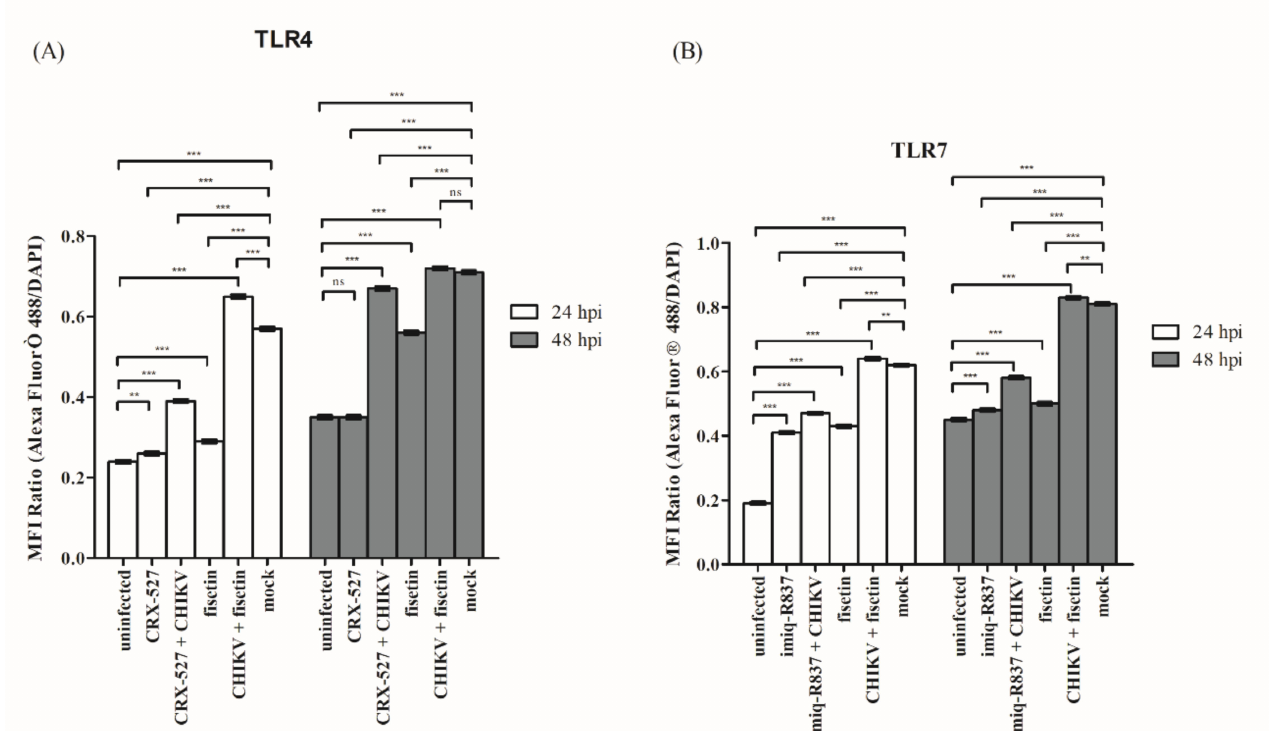
Figure 3. The mean fluorescence intensity (MFI) ratio of endogenous TLR4 and TLR7 protein in relation to DAPI. Data ( A ) TLR4 MFI ratio and ( B ) TLR7 MFI ratio are representative of three inde- pendent experiments and values are expressed as mean ± SD. CHIKV infection was performed using MOI = 1. One-way ANOVA ( p < 0.0001) and Dunnett’s multiple comparison post-test (** is p < 0.01 and *** is p < 0.001) were performed by setting uninfected and mock Huh7 cells as an independent control,